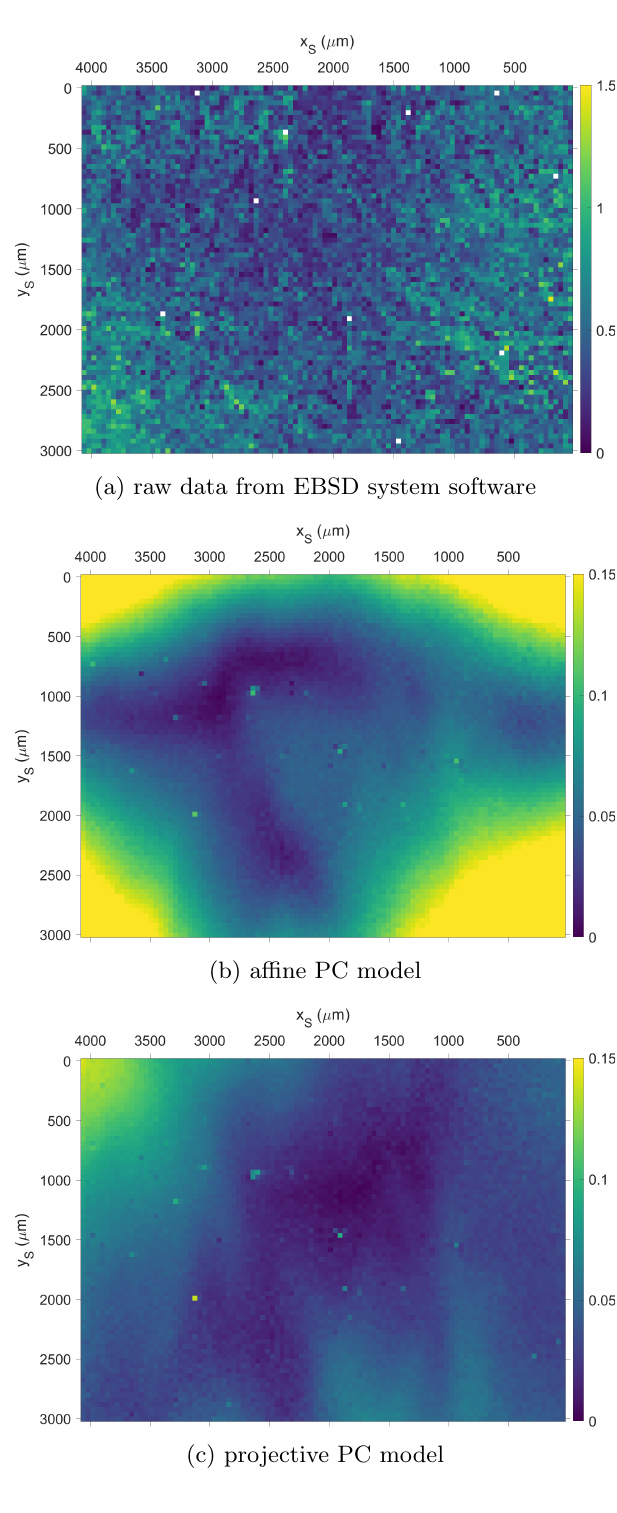
Figure 5. Maps of the misorientation angle to the mean orientation. ( a ) raw data from EBSD system, ( b ) refined orientations using affine PC calibration, ( c ) refined orientations using projective PC calibration. Scale in degrees, note that the scale for the raw data in ( a ) is increased by a factor of